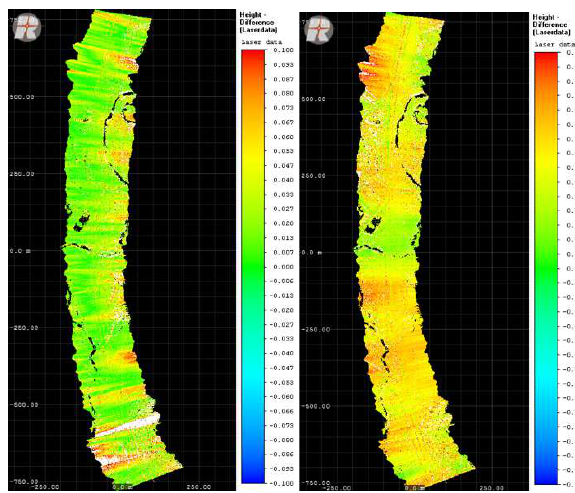
Figure 9: Strip 3 discrepancies between AIRINS and Navchip (fused) on left or APX15 on right.